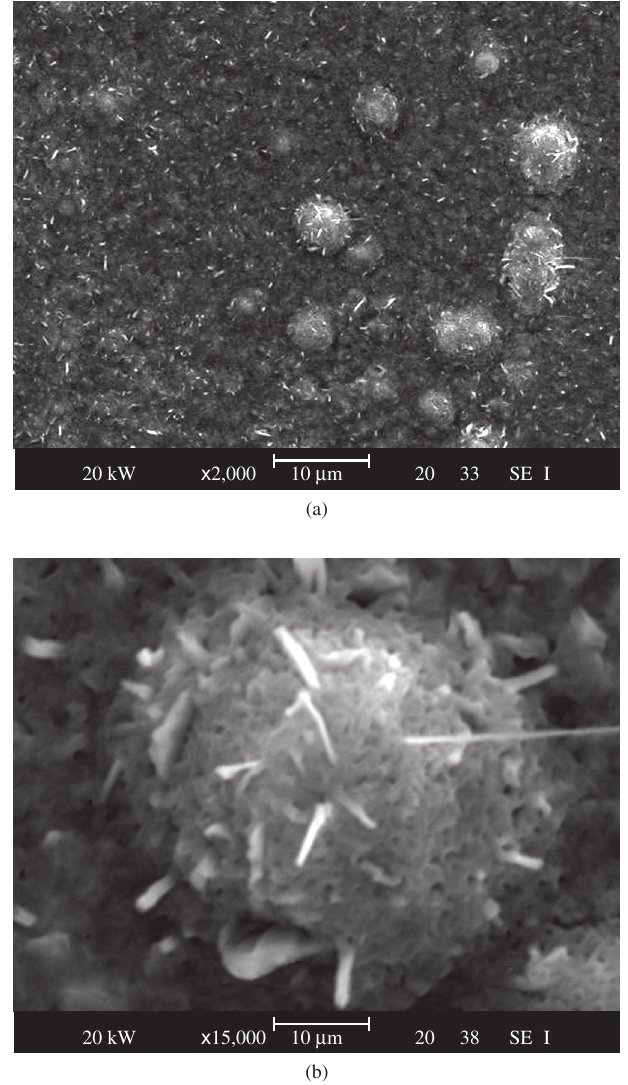
Figure 7. a) Spherical particles dispersed on the oxide film grown on the 430E steel after oxidation at 950 °C, for 50 hours. b) Whiskers emanating from the particle. /H 2 2